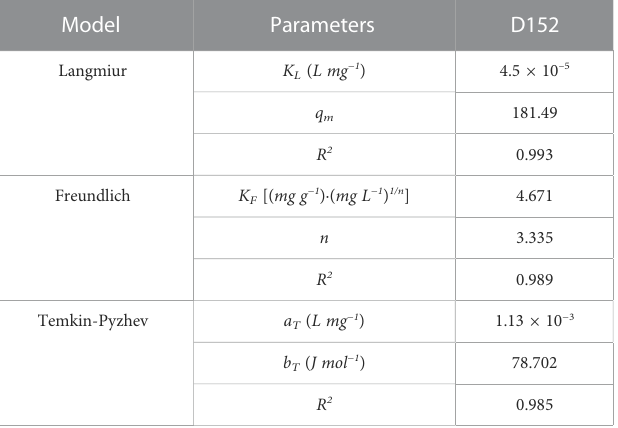
TABLE 2 Relevant parameters of the Langmiur, Freundlich and Temkin-Pyzhev adsorption isothermal models.